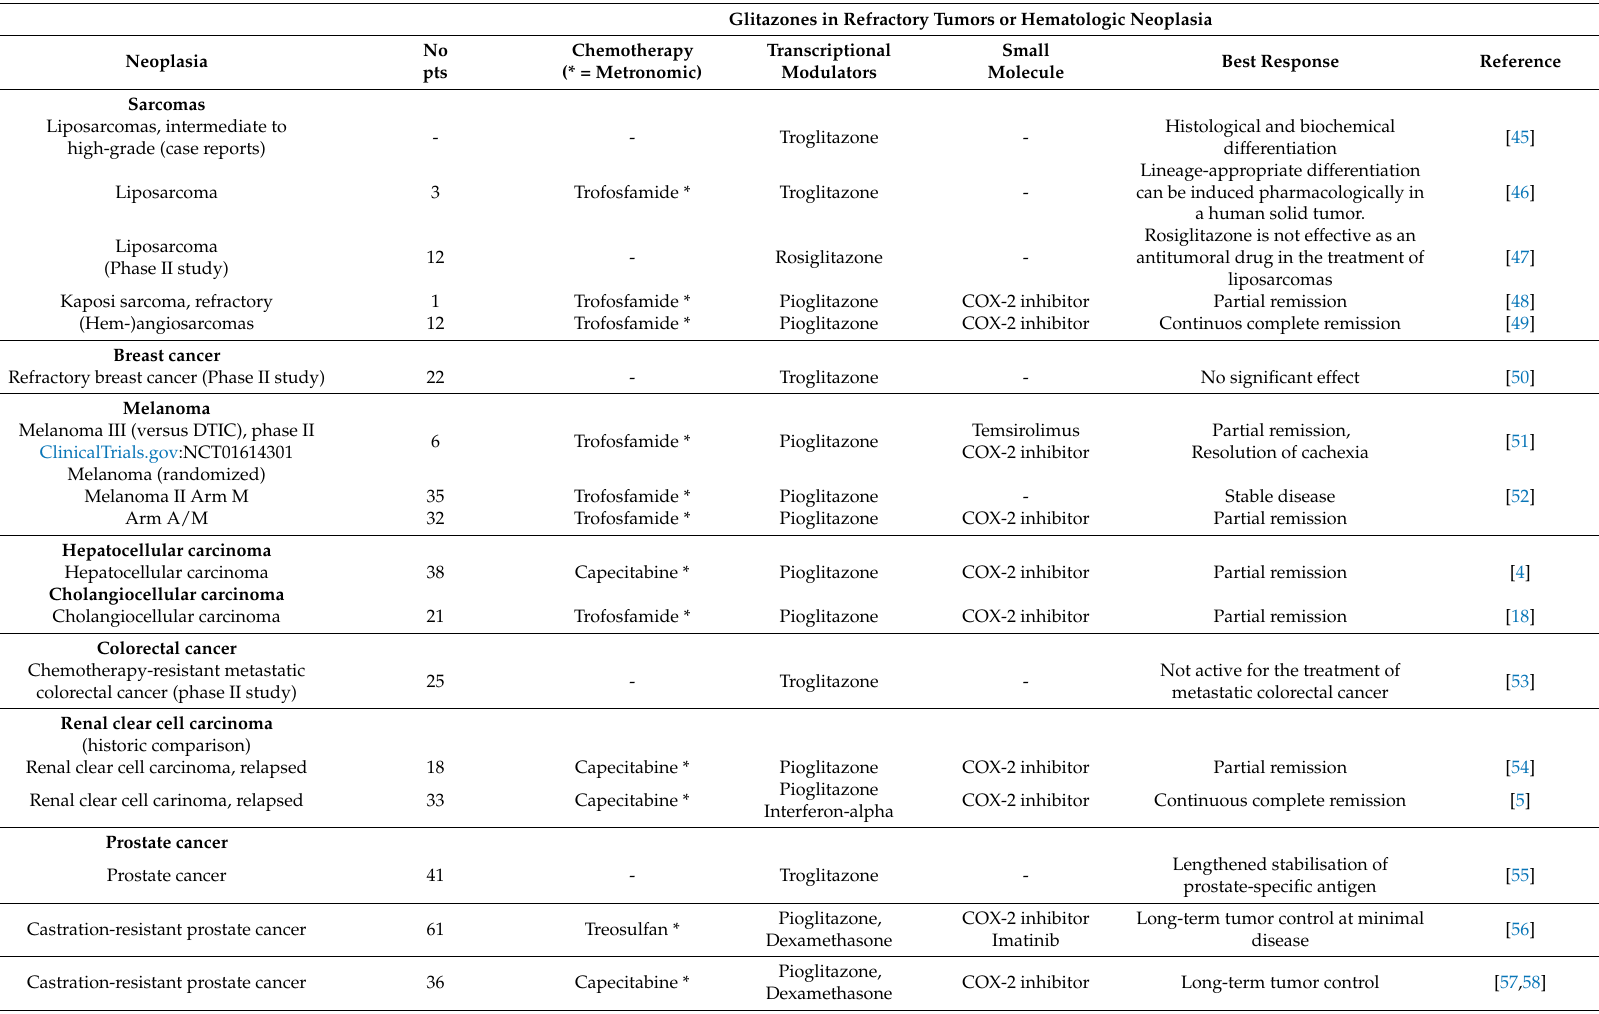
Table 2. Glitazones including treatment schedules in metastatic cancer or hematologic